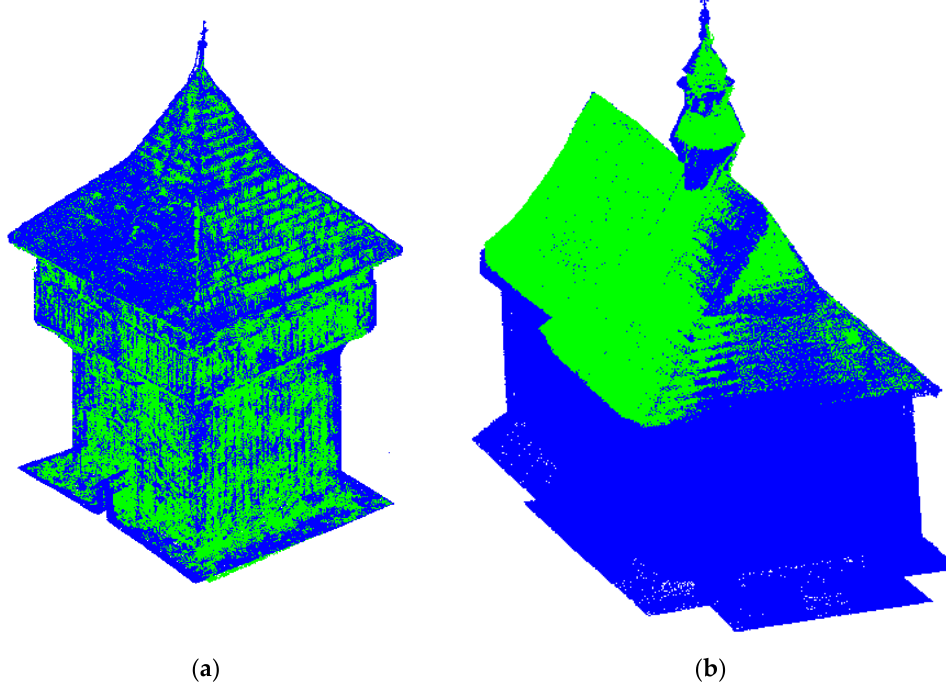
Figure 5. TLS (blue) and UAV (green) geospatial data integration for: ( a ) belfry, ( b ) St. Anna.